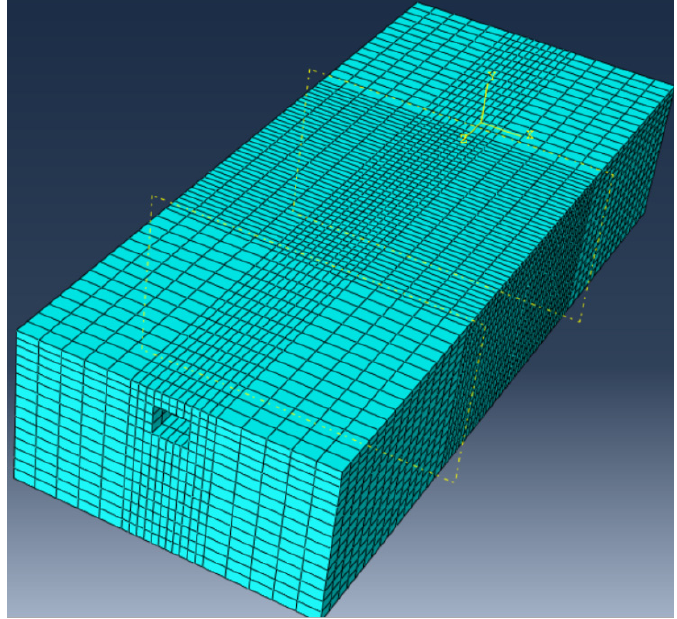
Figure 5. Meshing of the soil.